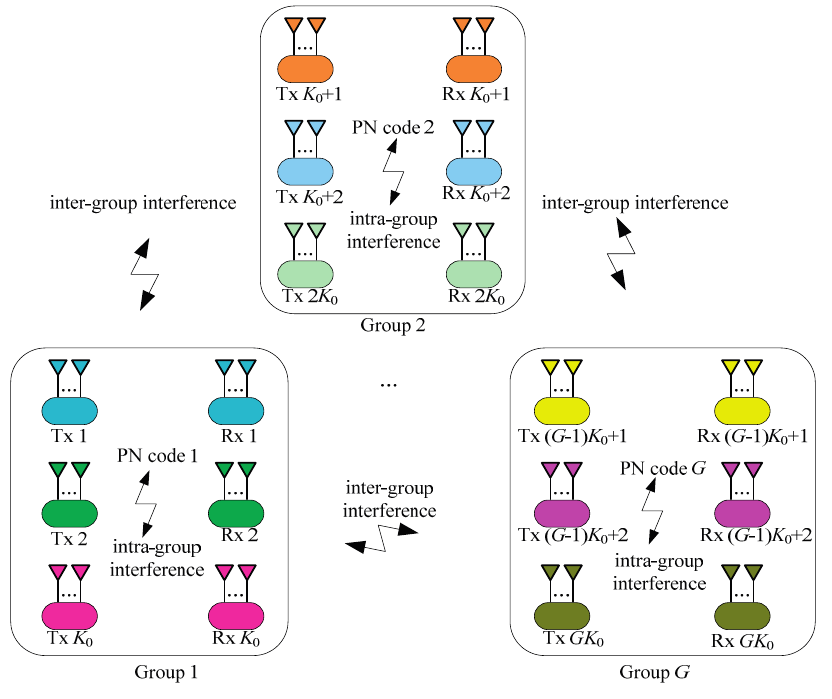
Figure 2. The JSCC-IA scheme with G groups and K 0 users in each